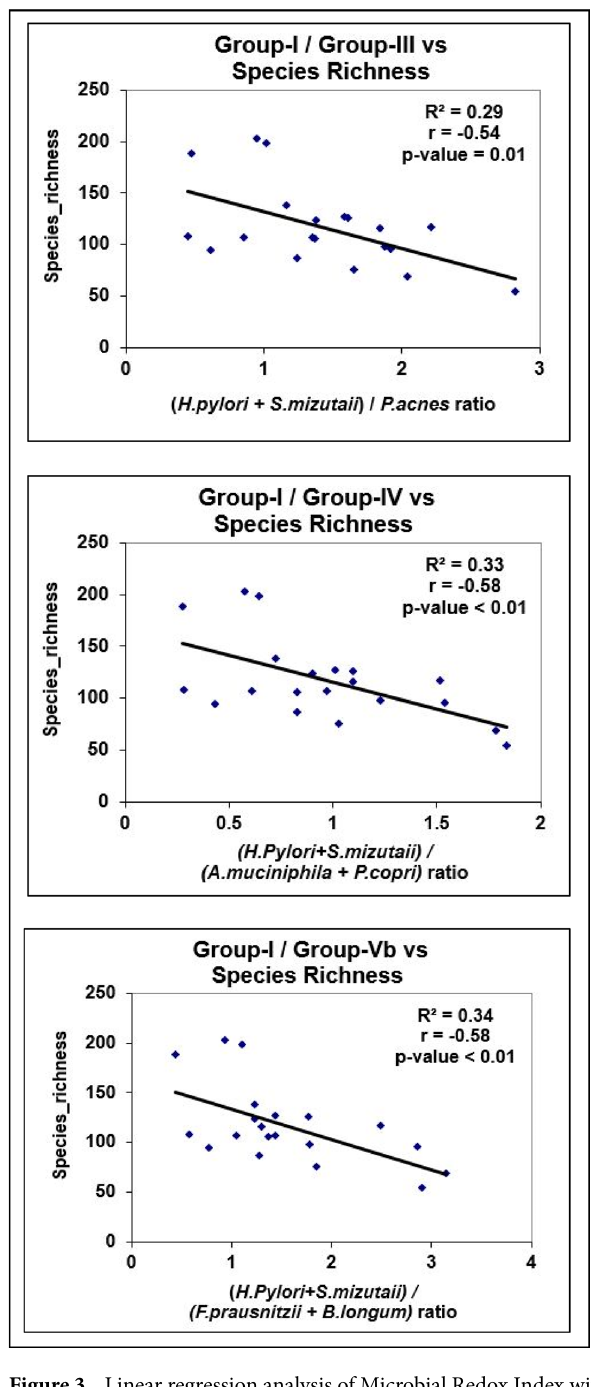
Figure 3. Linear regression analysis of Microbial Redox Index with Species